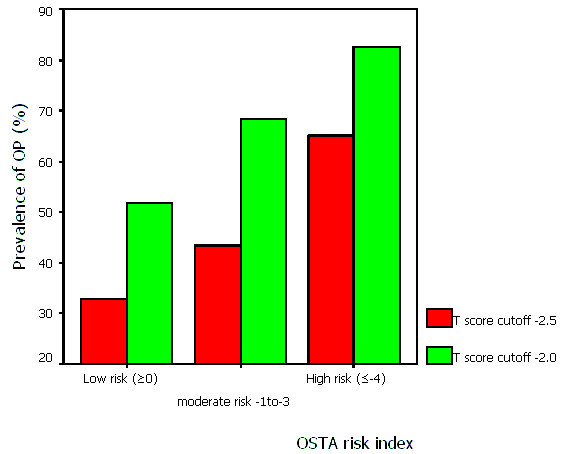
Prevalence of osteoporosis according to various T score cutoffs at different levels of OSTA risk index. (Categorization used in Asian women by koh et al[4]. Numbers of women in low, moderate, and high risk group are 110, 92, 16, respectively.)